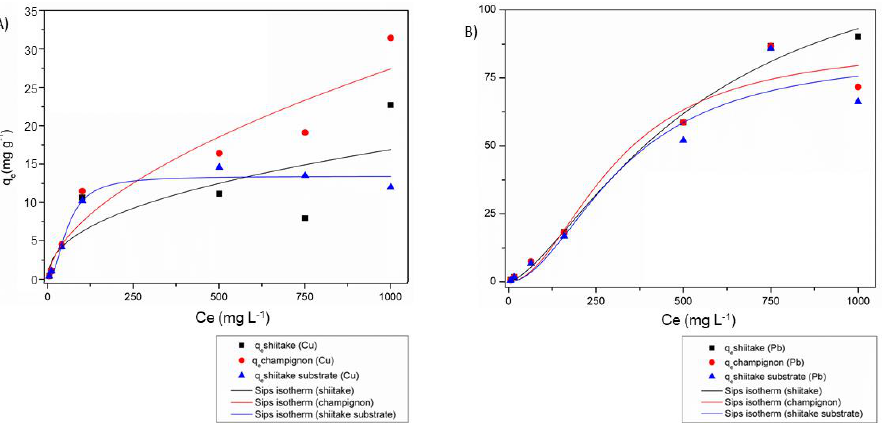
Figure 2. Sips theoretical isotherms to Copper (Cu) ( A ) and Lead (Pb) ( B ) by stalks of shiitake, stalks of champignon, and substrate of shitake. C e and q e correspond to the equilibrium concentration (mg/L −1 ) and the amount adsorbed in equilibrium (mg/g −1 ), respectively.